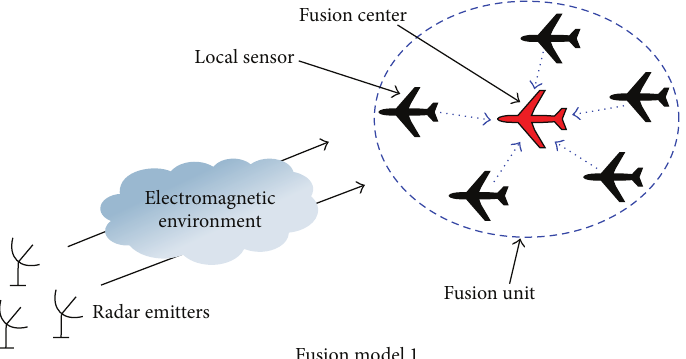
Figure 5: The same kind of platforms fusion model. In fusion model 1, the radar emitter pulses are intercepted by different local sensors from different orientations and altitudes in the fusion unit, and then the processed pulses are sent to the fusion center to do data fusion.